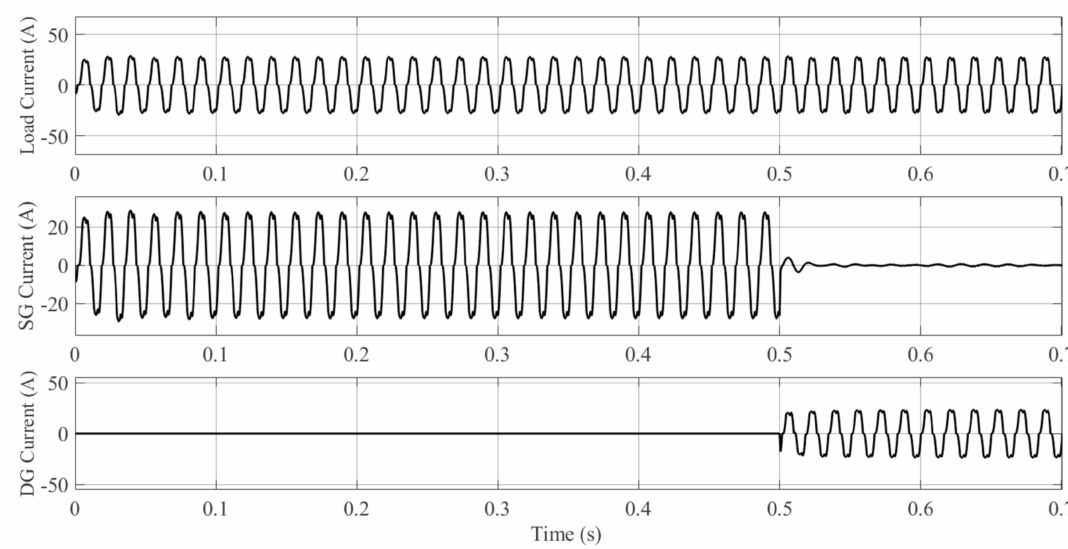
Figure 20. Load, SG and DG currents before and after connection of the DG to the SG at t = 0.5 s.